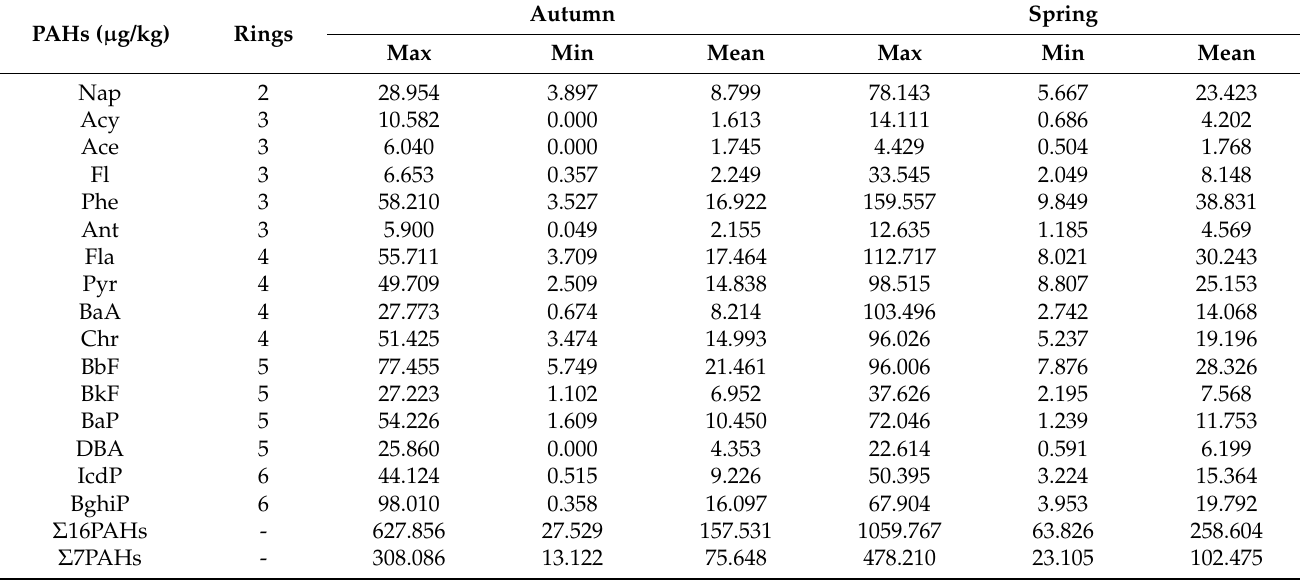
Table 3. The concentrations of 16 PAHs in farmland soils in autumn and